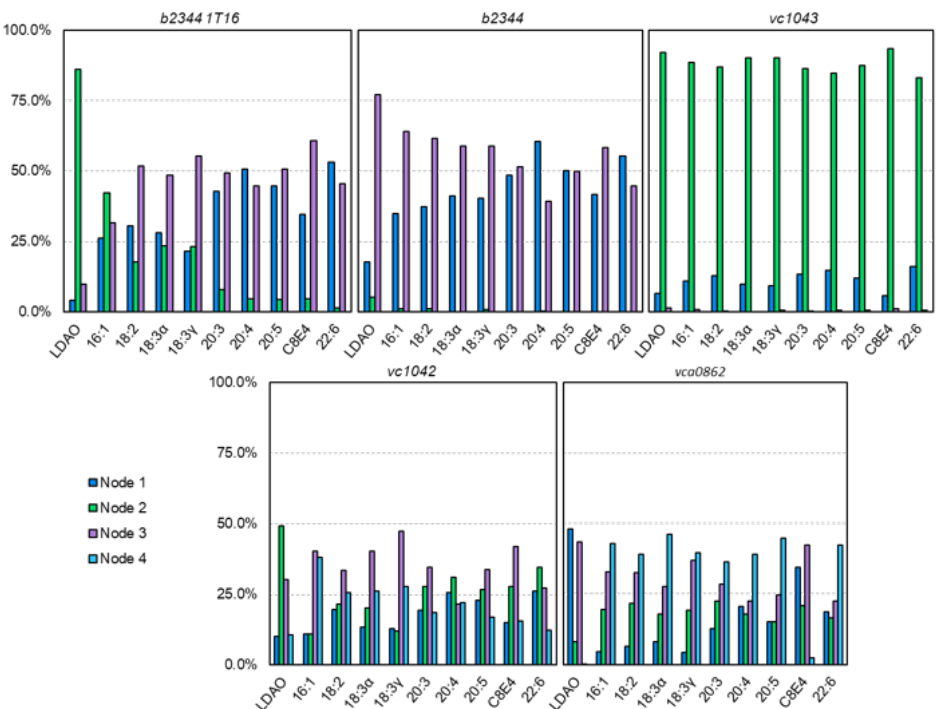
Figure 7. Charts of FAs by type located around certain nodes. The % is out of the 500 docked instances of each FA type over the 50 frame trajectory. The b2334 , b2334 , and vc1043 docking resulted in three nodes, while vc1042 and vca0862 resulted in four